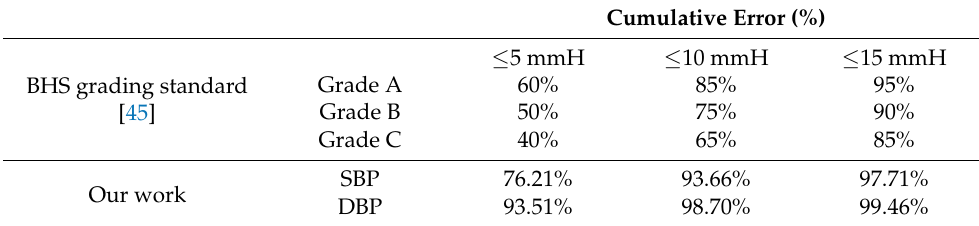
Table 4. Comparison of the result with British Hypertension Society (BHS) grading standard.